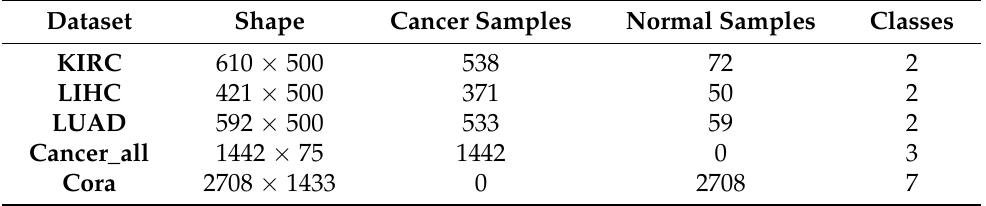
Table 3. Datasets